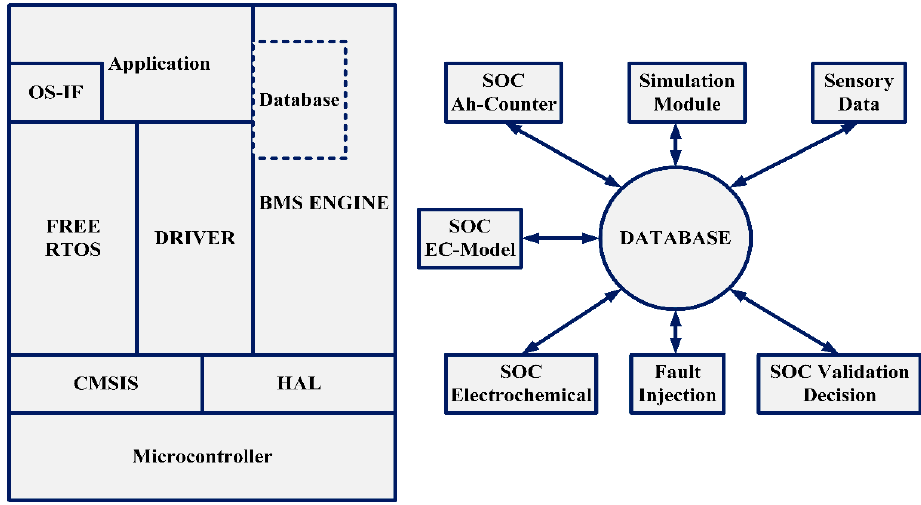
Figure 3. BMS software architecture.